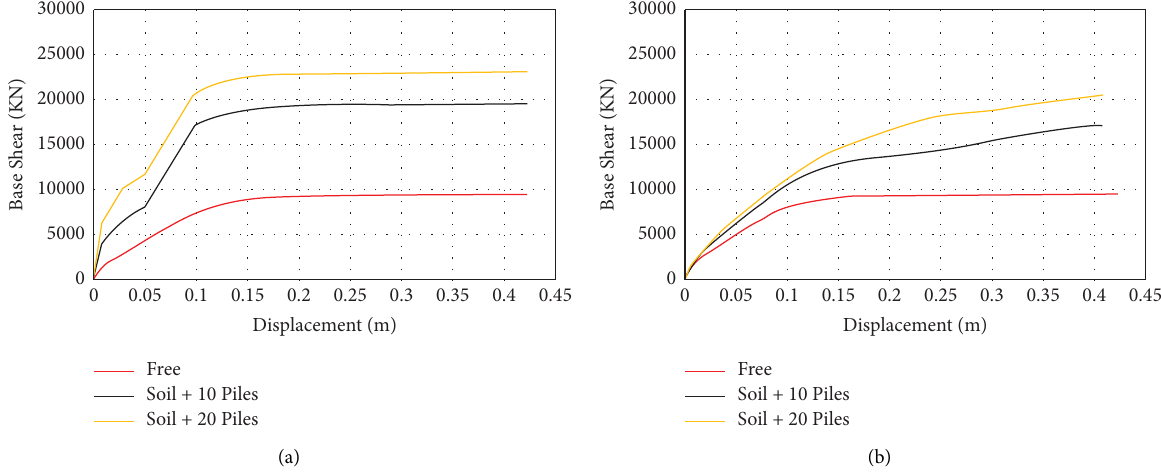
Figure 10: Pushover curves of F1, L1, and H1 bridge models in (a) longitudinal and (b) transverse directions.